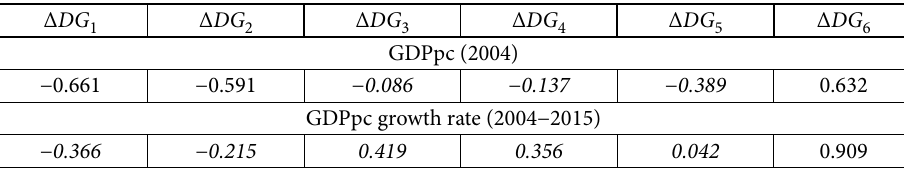
Table 5. Correlation* between the development gaps and GDP per capita in Polish regions (2004–2015) (source: own calculations) ∆ DG 1 ∆ DG 2 ∆ DG 3 ∆ DG 4 ∆ DG 5 ∆ DG 6